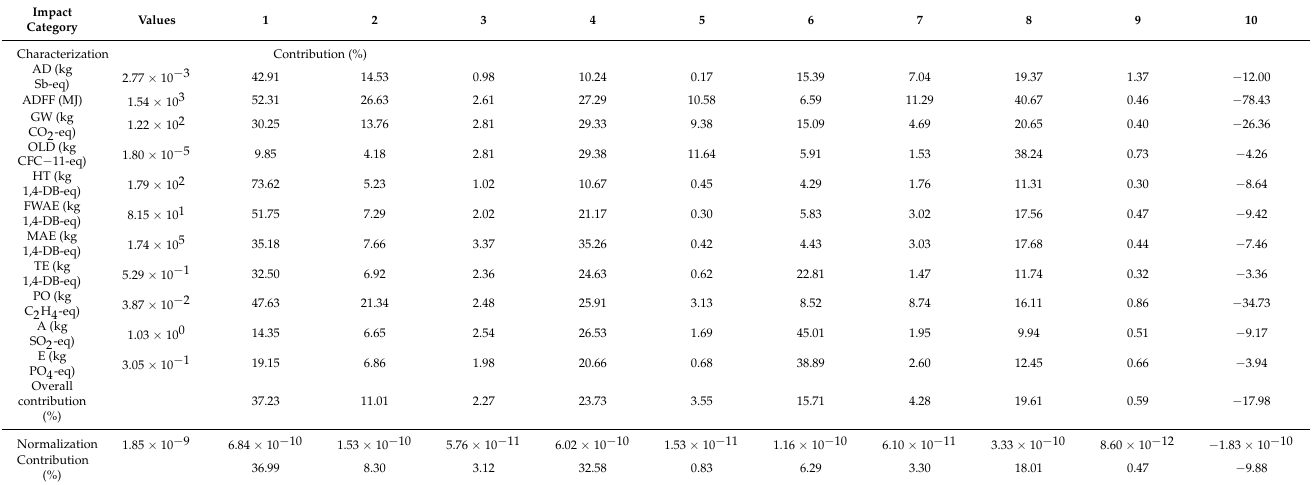
Table 6. Characterization of the potential environmental impacts and the contributions of the components of the system; normalized values and their contributions to the environmental